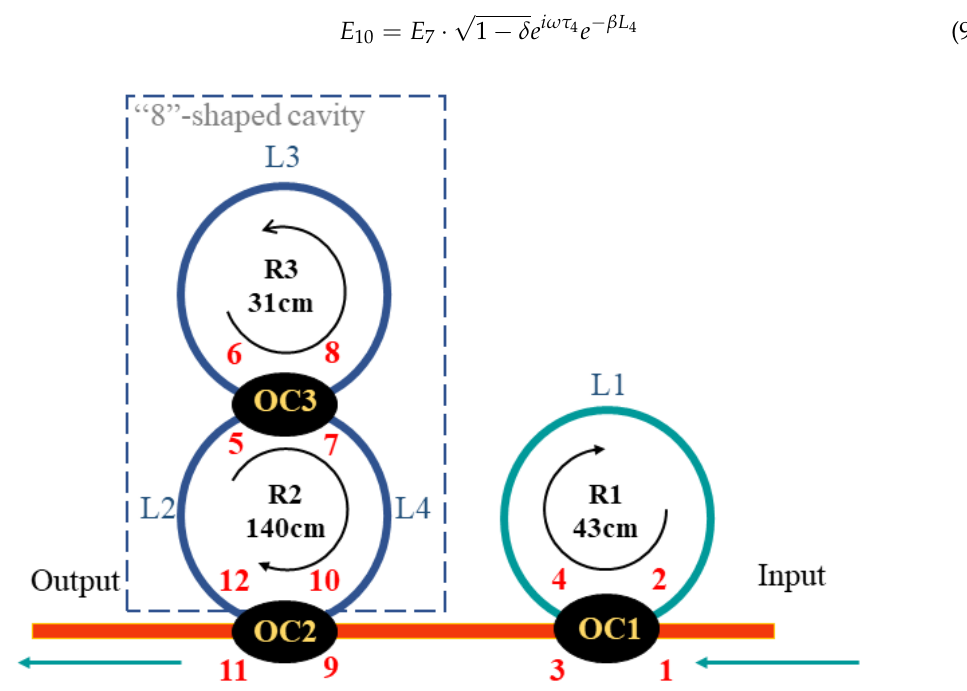
Figure 3. Schematic diagram of the three-loop MSCs filter. The input and output ports were cycled enough times to reach a steady